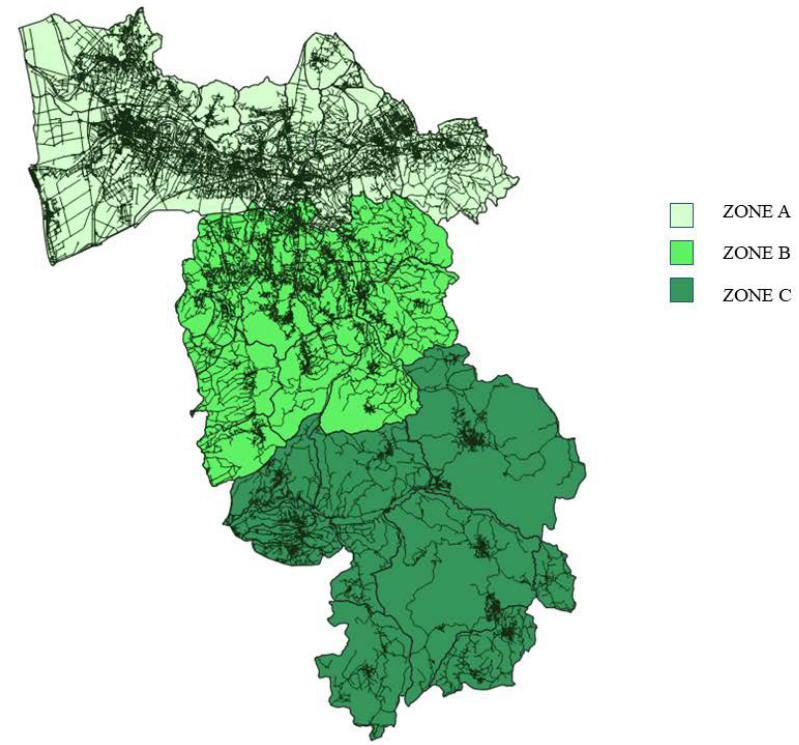
Figure 2. Development of the road network in the province of Pisa.